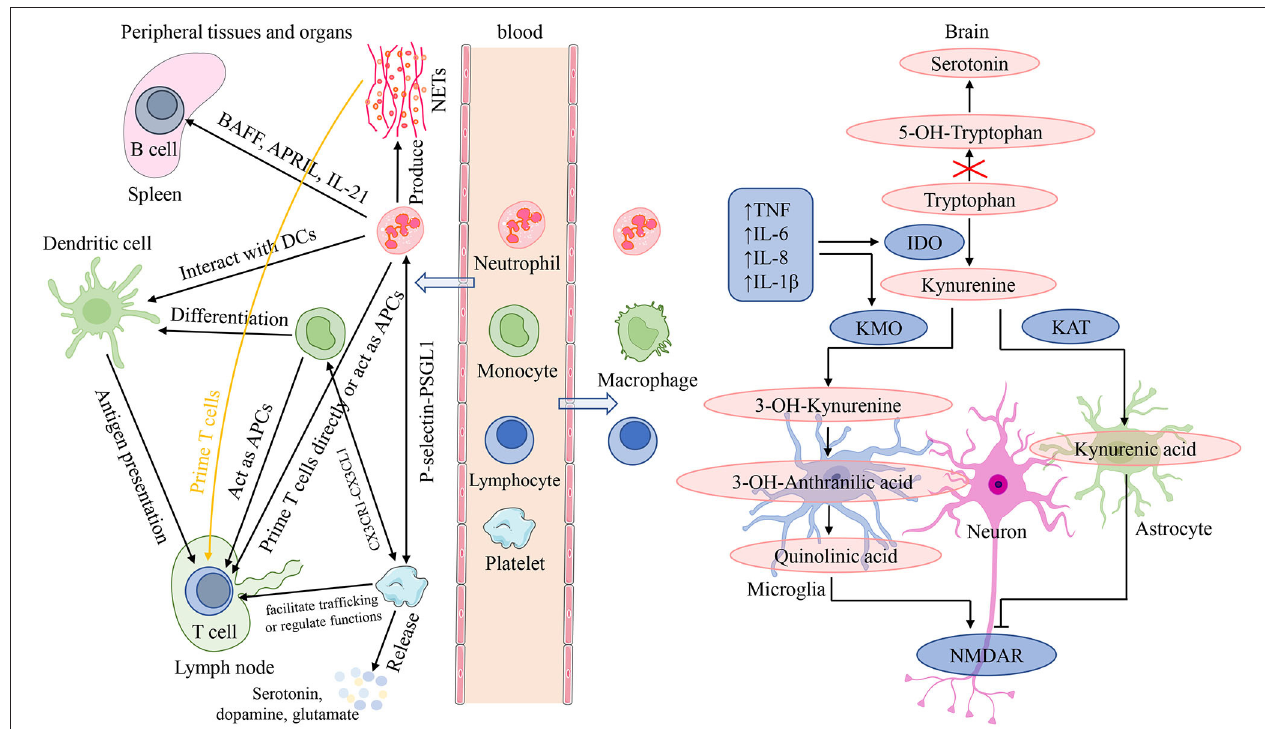
FIGURE 5 | Interactions among peripheral blood cells and their involvement in the mechanisms of neuroinflammation induced depressive symptoms. In the presence of an inflammatory stimulus or infection, in addition to playing a role in recognizing, phagocytosis and killing pathogens, neutrophils can also interact with adaptive immunity. On the one hand, neutrophils can migrate to the spleen and induce T1 antibodies production by activating B cells through the productions of BAFF, APRIL and IL-21; while production of T1 antibodies helps to increase the phagocytic and clearance capabilities of neutrophils. On the other hand, neutrophils can facilitate the activation and differentiation of T cells through several following pathways: present antigens directly; by the release of NETs; acting as APCs; transfer antigens to dendritic cells. Monocytes can migrate into systemic tissue and differentiate into macrophages and dendritic cells, and play three major functions in immune responses: phagocytosis, antigen presentation, and cytokine production. For lymphocytes, they are the main effectors of adaptive immunity which facilitate pathogen-specific immune recognition, antibody, cytokine and immune memory production, cytotoxicity, and so on. Platelets are important effectors of innate and adaptive immunity: interact with neutrophils mediated by the P-selectin/PSGL1 axis; form the platelet-monocyte complexes through binding of platelet-expressed CXCR1 to CXCL1 of monocytes; facilitate T cell trafficking or regulate T cell functions. In addition, platelets can release serotonin, dopamine, glutamate, and so on. Chronic stress can disrupt the blood-brain barrier and increase access of peripheral cells to infiltrate directly into the brain. After migration into brain lesions, peripheral inflammatory cells (neutrophils, monocytes, and lymphocytes) may exacerbate brain injury and neuronal damage by releasing pro-inflammatory cytokines and